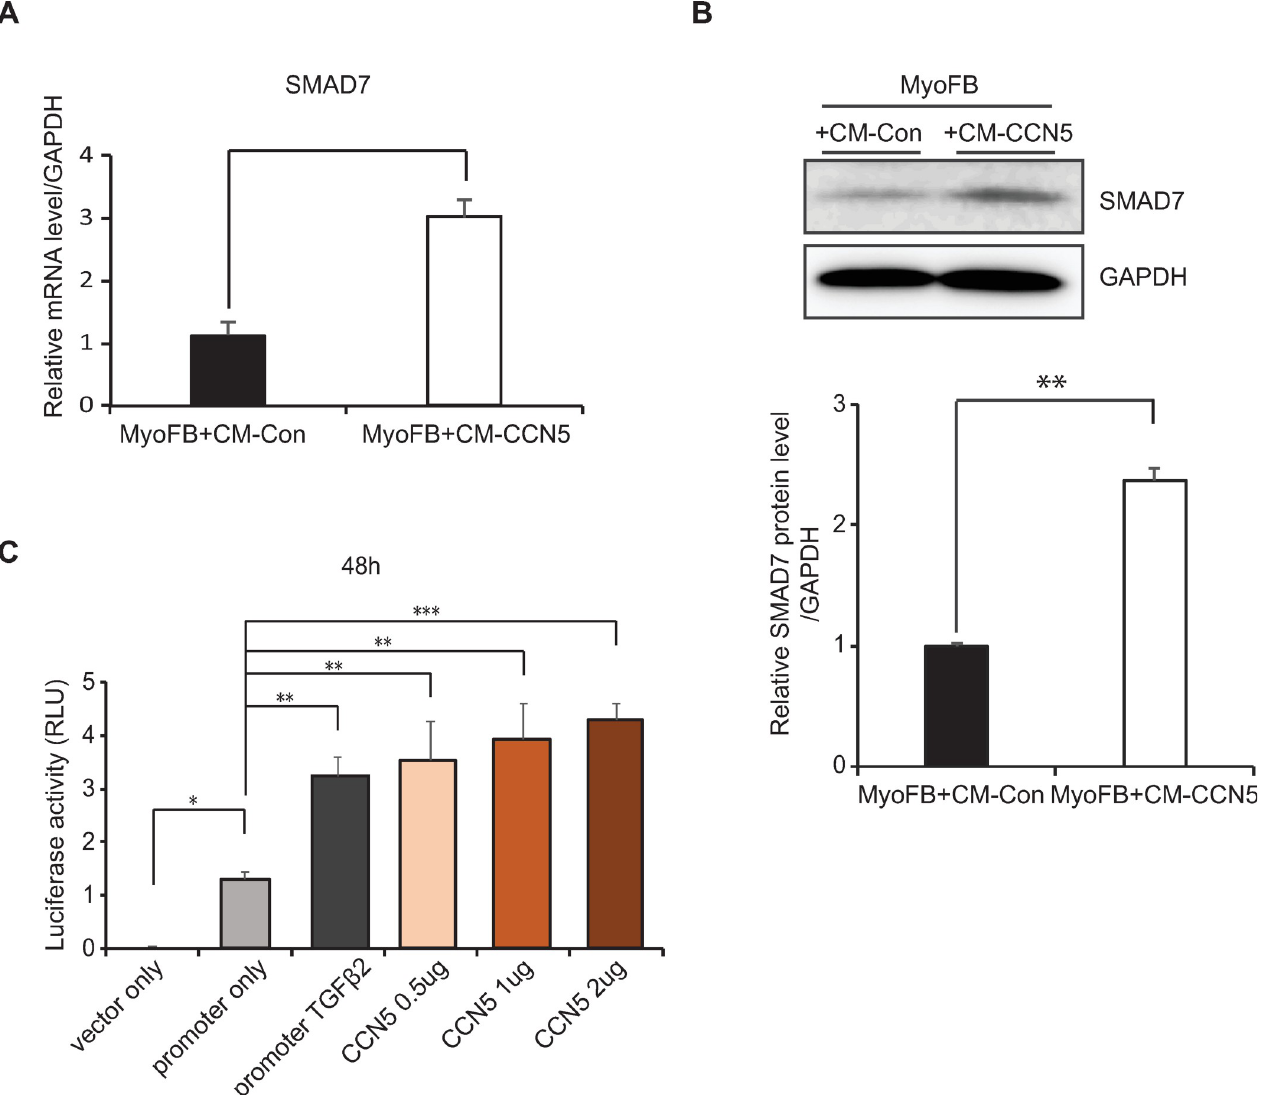
Fig 5. CCN5 regulates the transcription of SMAD7 . Freshly prepared FBs were transfected with 25 nM SMAD7 siRNA and were trans-differentiated to MyoFBs by treating them with 10 ng/mL TGF- β for 48 hours. MyoFBs were then cultured in control conditioned media (CM-Con) or CCN5-containing conditioned media (CM-CCN5) for a further 48 hours. (A) Cell lysates were used for western blotting analysis of SMAD7. (B) Total RNA was prepared from cell lysates and used for qRT-PCR analysis. (C) A reporter construct for monitoring transcription from the SMAD7 promoter was constructed. This reporter construct and CCN5-expressing plasmids were co-transformed into MyoFBs. Luciferase activity was measured 48 hours after transformation. The result is the ratio of luminescence intensities (RLU, Relative light Unit) of the Gluc over SEAP (S). Compare the normalized Gluc activity (RLU/S) of all samples. TGF- β was used as a positive control, and empty plasmid was used as a negative control. For each group, three independent cultures were prepared and treated (n = 3). � P < 0.05, �� P < 0.01, ��� p <